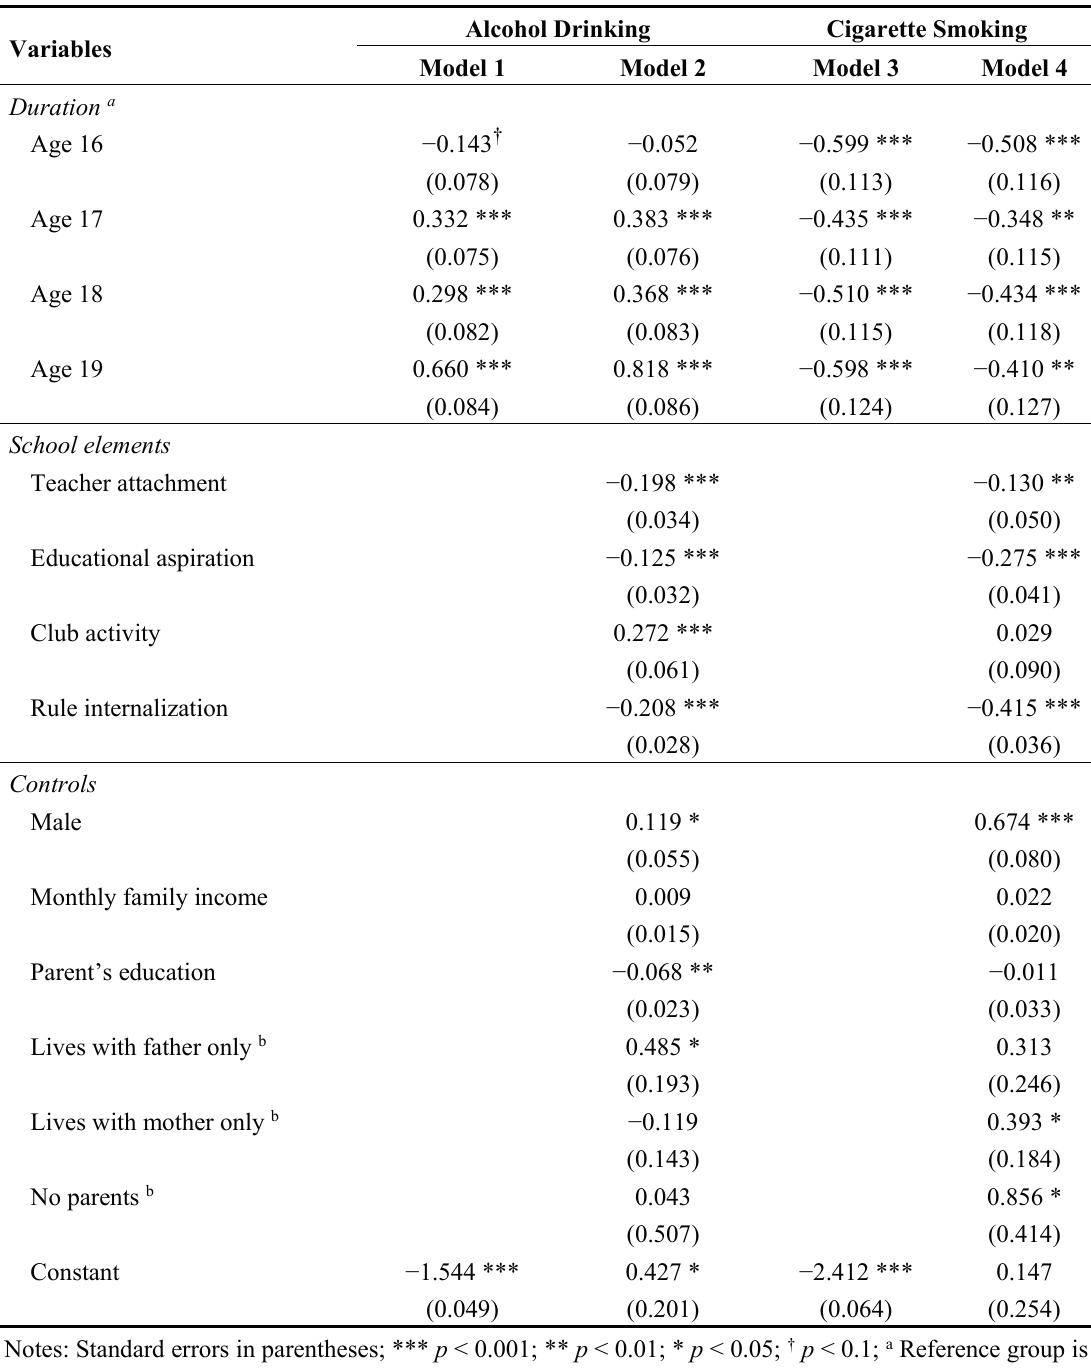
Table 4. Discrete time logistic regression: onset of alcohol drinking (n = 9242) and cigarette smoking (N =